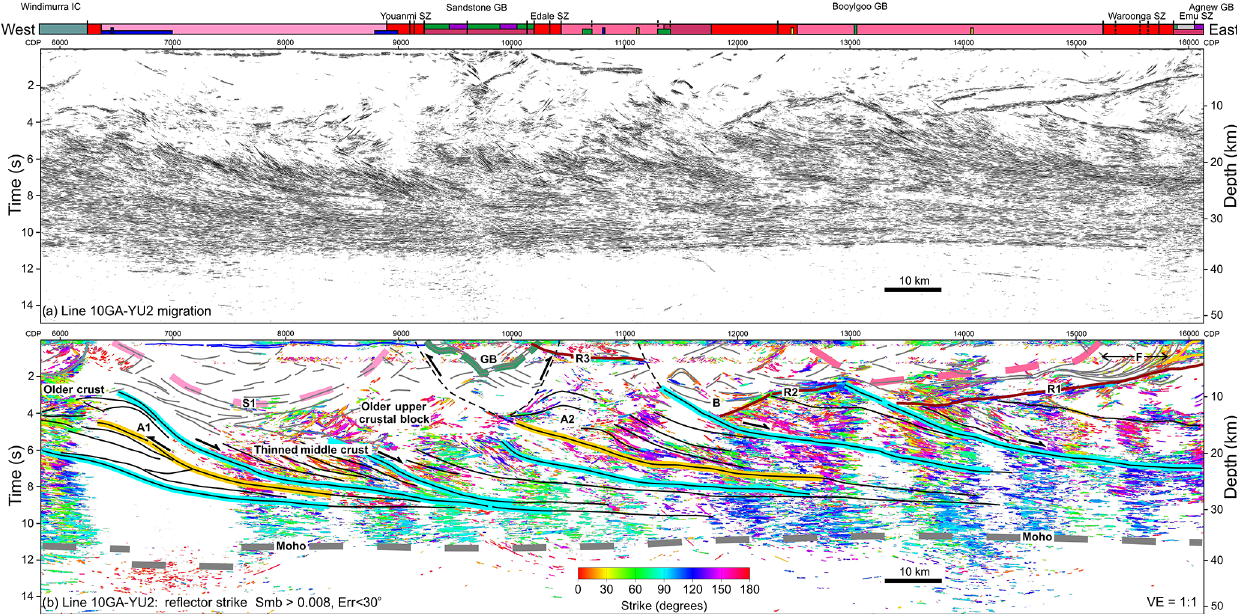
Figure 3. Line 10GA-YU2: (a) F-K migration, (b) migrated reflector strike with interpretation from Calvert and Doublier (2018); only arrivals with semblance greater than 0.008 and strike estimation error less than 30 ◦ are included. Pink to dark red: granitoid rocks and gneiss; green, dark green: mafic volcanic rocks; purple; ultramafic volcanic rocks; grey: sedimentary rocks; yellow and blue: Proterozoic sill.